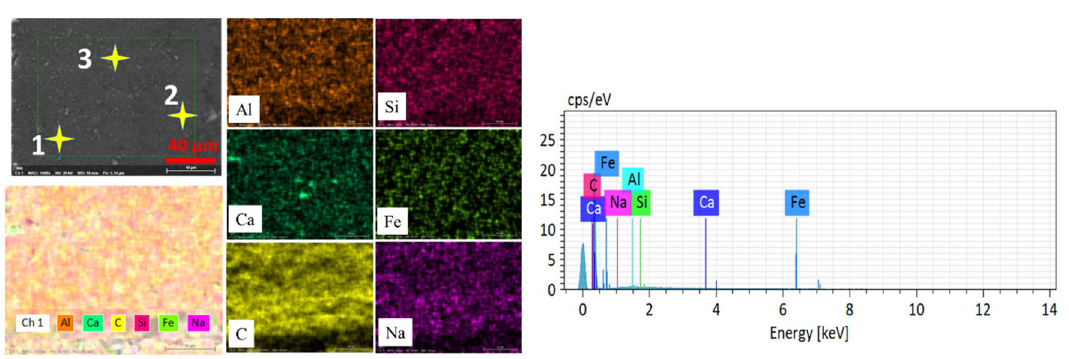
Figure 19. EDX mapping of the